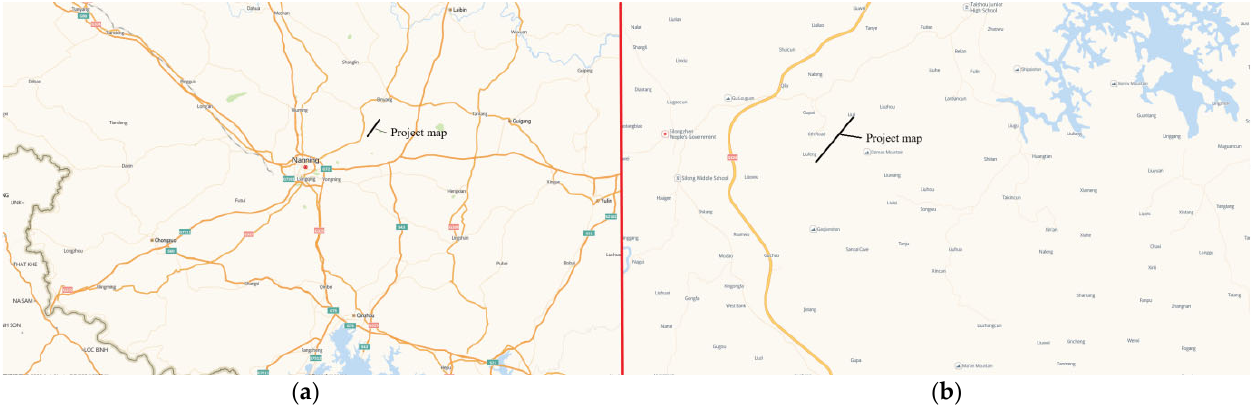
Figure 1. Project Location map. ( a ) Large map. ( b ) Mini map.